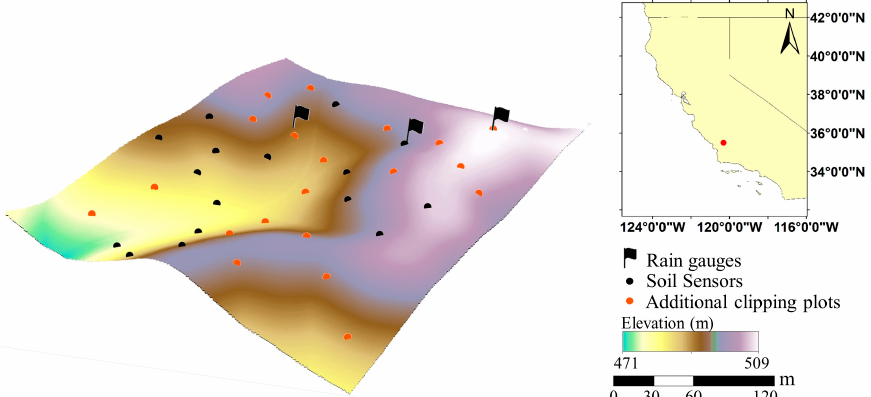
Figure 1. Topography of the study area (35.5N, 120.3W) on Central Coast, California, from sUAS-derived digital surface model. The study area features large topographic variation including a valley, a hilltop, and many concave and convex slopes. The soil sensors (in black) and additional 20 biomass clipping plots (in red) were distributed in multiple topographic positions.